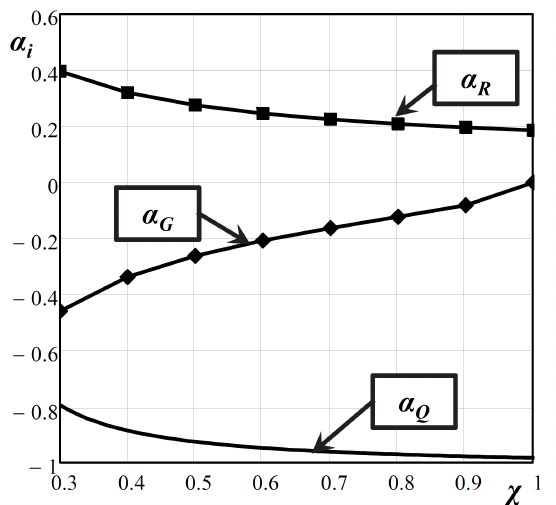
Figure 1. Variation of sensitivity factors with χ .